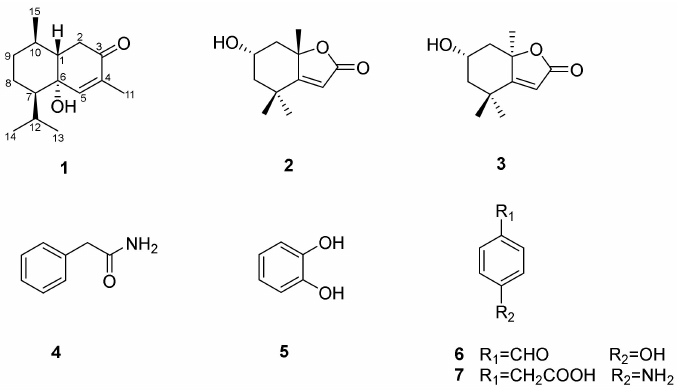
Figure 1. Chemical structures of 1 – 7